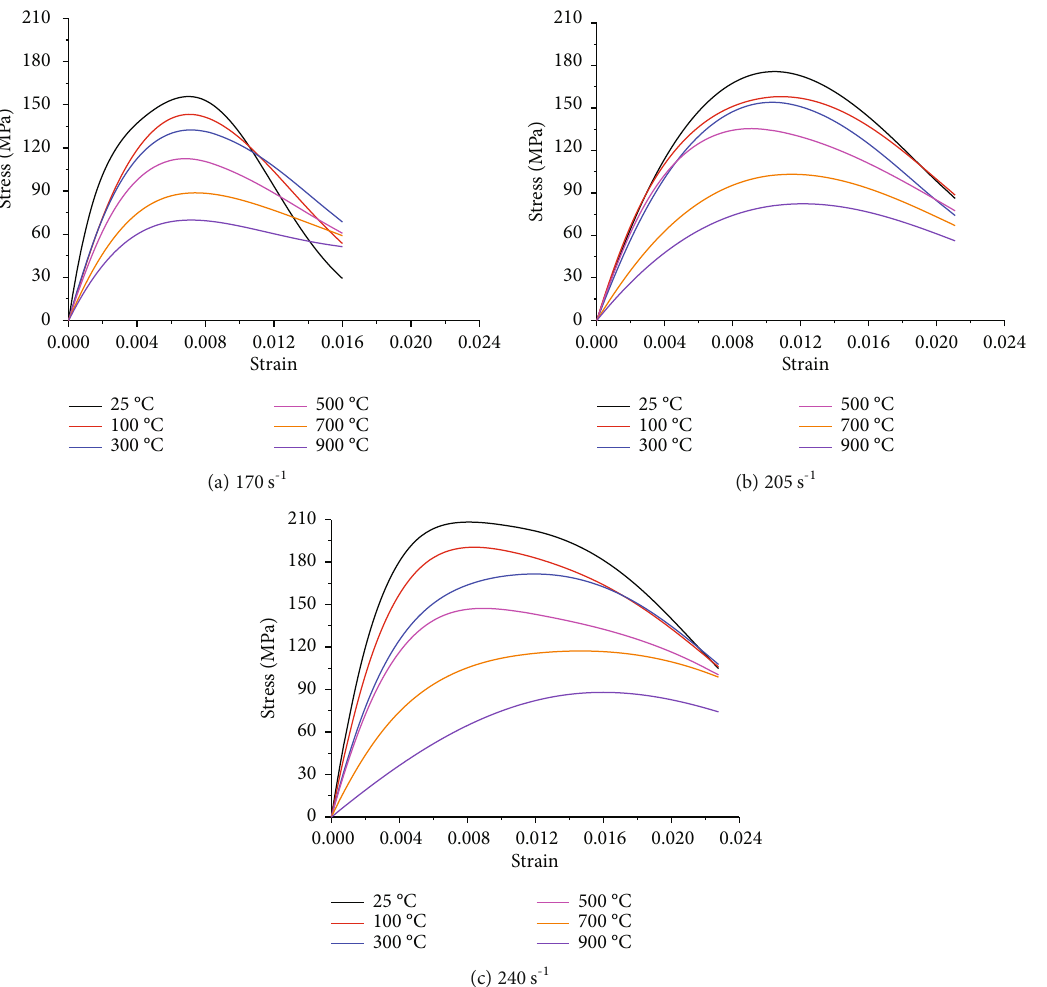
Figure 10: The theoretical dynamic stress-strain curves of deep sandstone specimen with various